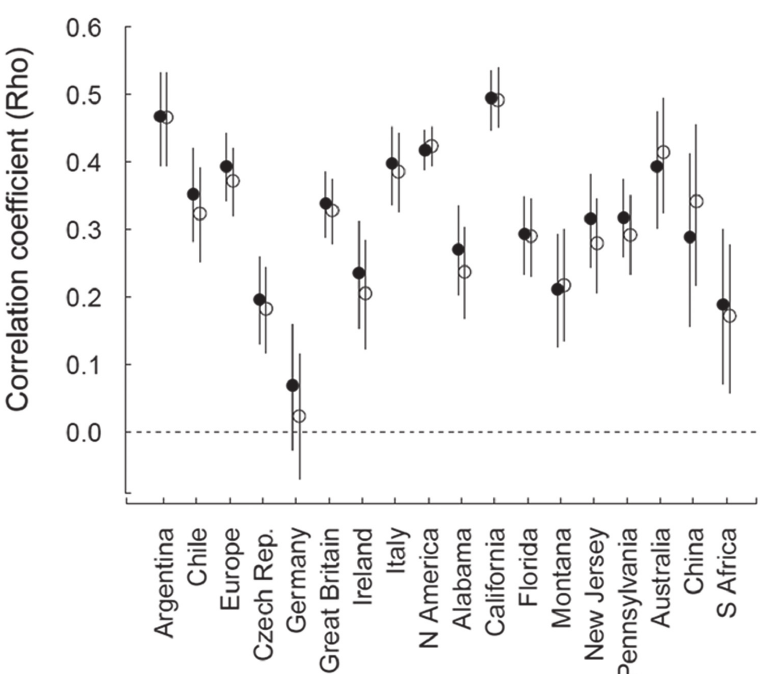
Figure s2. Spearman’s ρ correlation coefficients of the relationship between the number of references in (closed circles), or the number of GCW areas occupied (open circles) according to the Global Compen- dium of Weeds (using ‘weed only’ references), and the distribution (number of units occupied) of species in 18 regions. GCW-invasiveness measures were calculated using all non-target region references. Error bars indicate bootstrapped, bias-corrected 95% confidence intervals; the dashed line signifies ρ